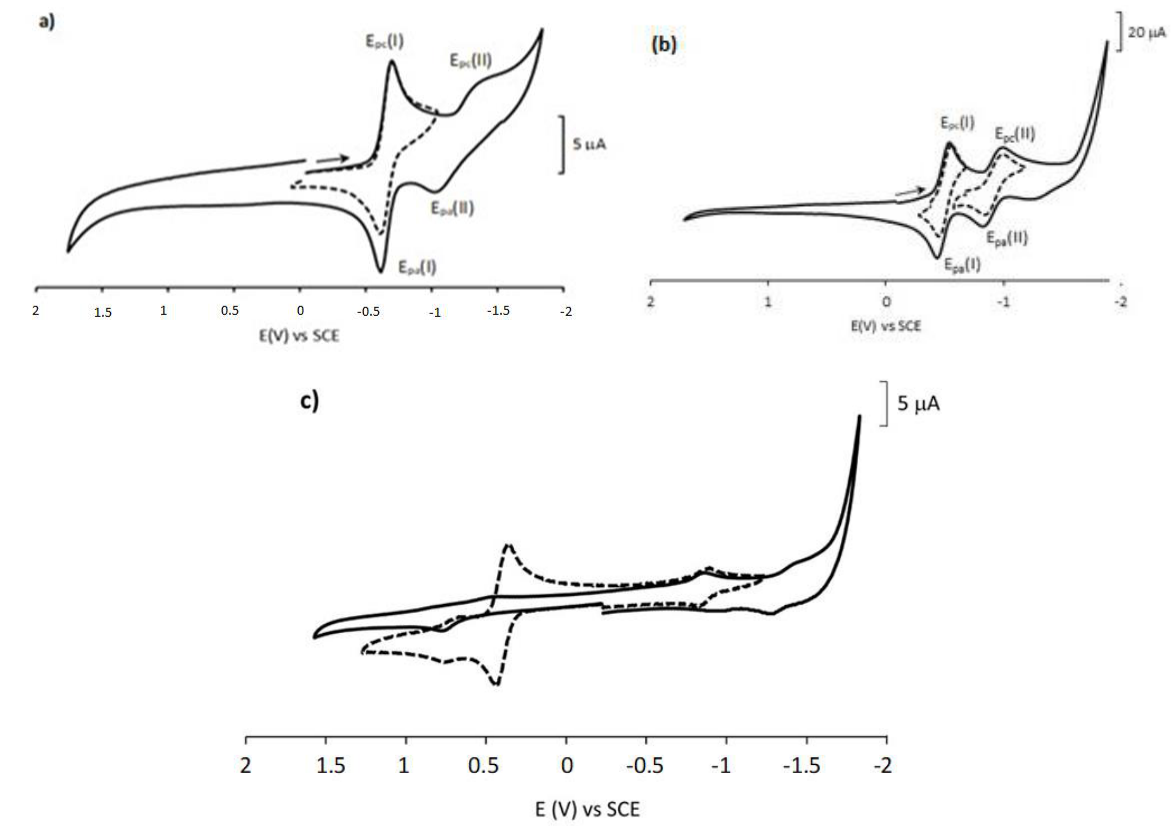
Figure 2. Cyclic voltammograms of ( a ) 1,4-NQ, showing the isolated redox process (dashed line);